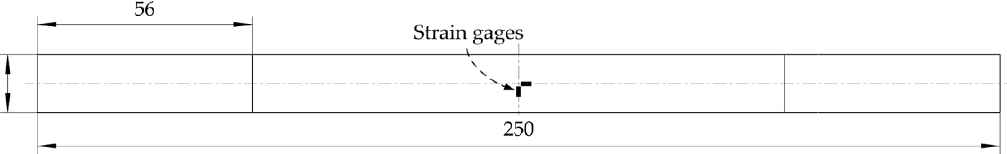
Figure A1. Dimensions of the longitudinal tensile specimens (mm).